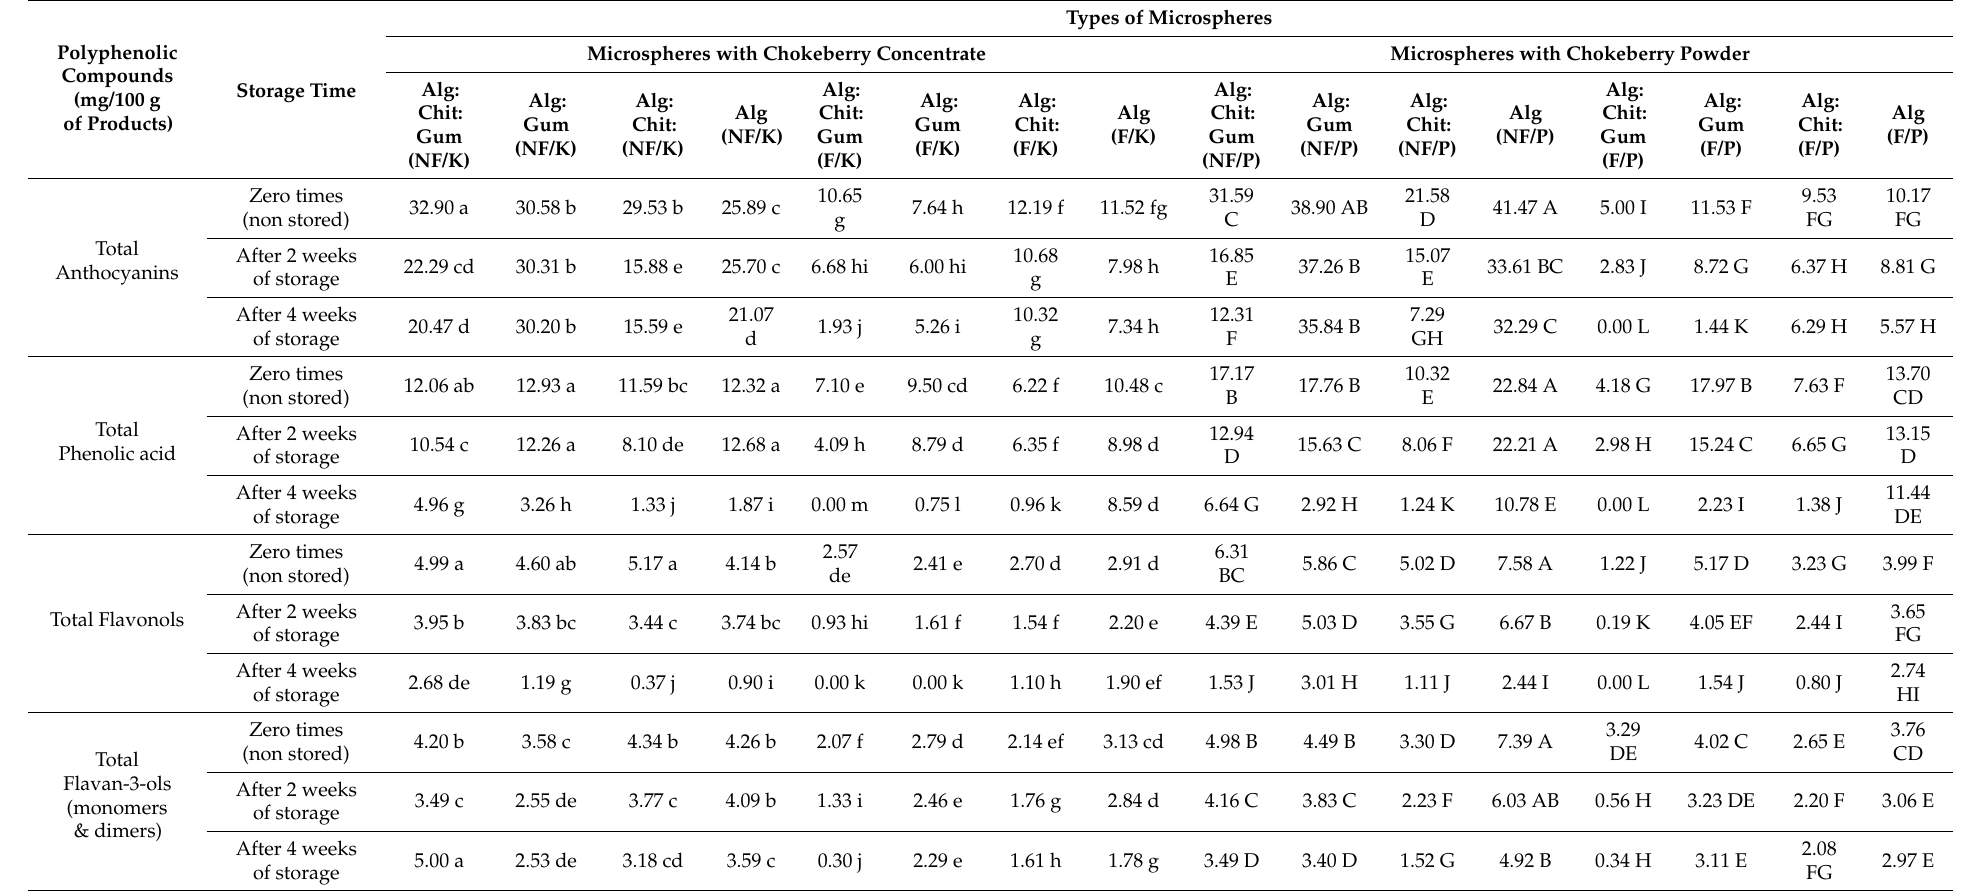
Table 1. Polyphenolic compounds of chokeberry microspheres (mg/100 g of